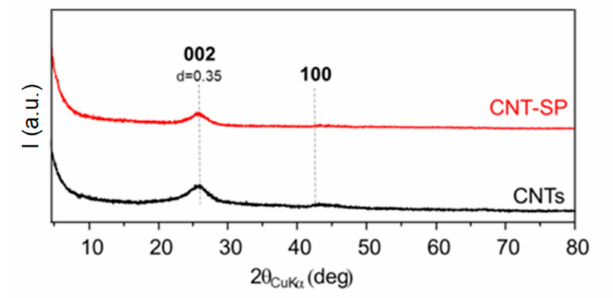
Figure 4. Wide angle X-ray di ff raction (WAXD) patterns of pristine CNTs (black) and CNT- serinol pyrrole (SP) adduct